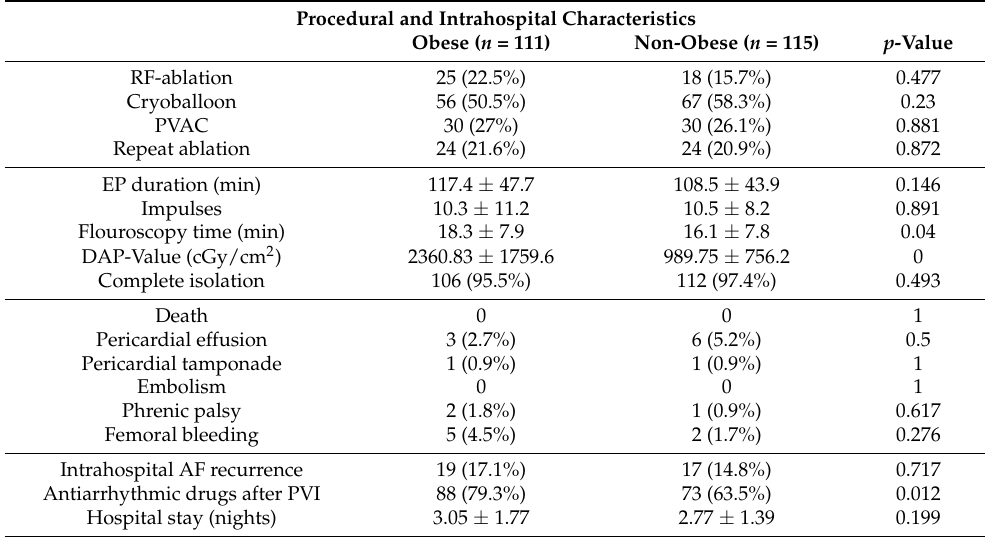
Table 2. Procedural and intrahospital characteristics.